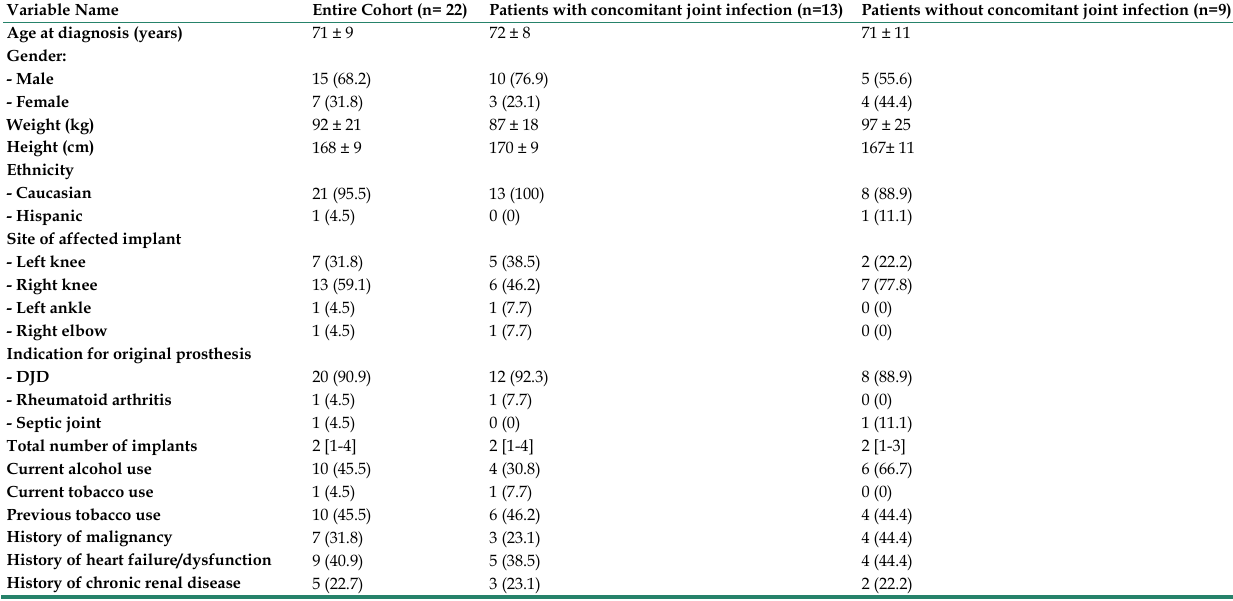
Table 1. Demographics and Medical Background of Patients with Prosthetic Joint and CPPD Documentation Variable